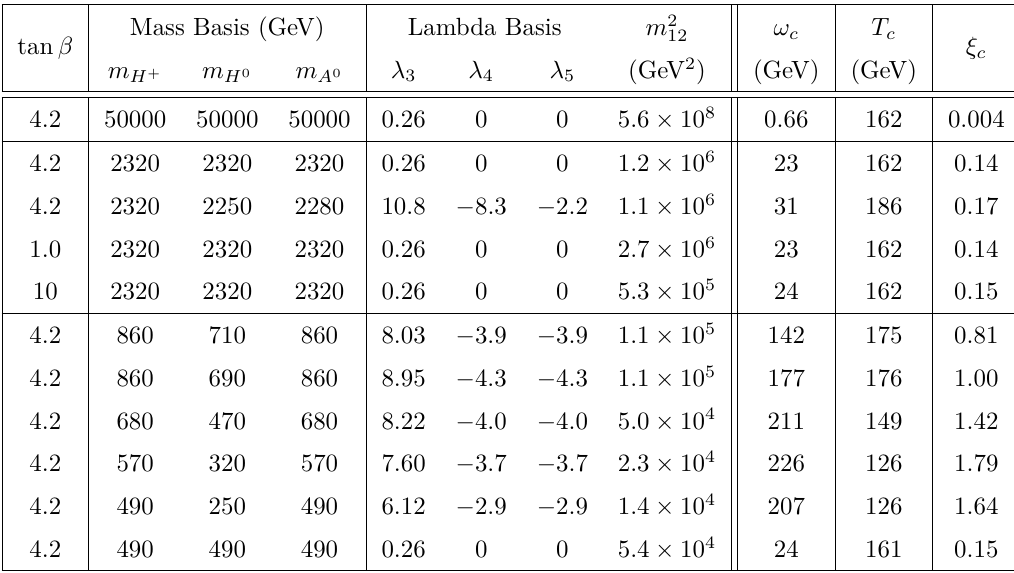
Table 3. Table of results for the EWPT in the 2HDM. We consider the exact alignment limit, cos( β − α ) = 0 , and in addition we employ the condition by eq. (7.6). In this limit, as follows from eqs. (2.11)–(2.15), one gets: λ 1 = λ 2 = m 2 /v 2 = 0 . 26 , i.e. λ 1 , 2 are fixed and independent of the h 0 Higgs masses and tan β (and therefore not again shown in the table). In addition, one obtains that λ 3 , 4 , 5 are independent of tan β , and λ 3 + λ 4 + λ 5 = m 2 /v 2 = 0 . 26 . For similar discussions of the h 0 lambda basis, see e.g.